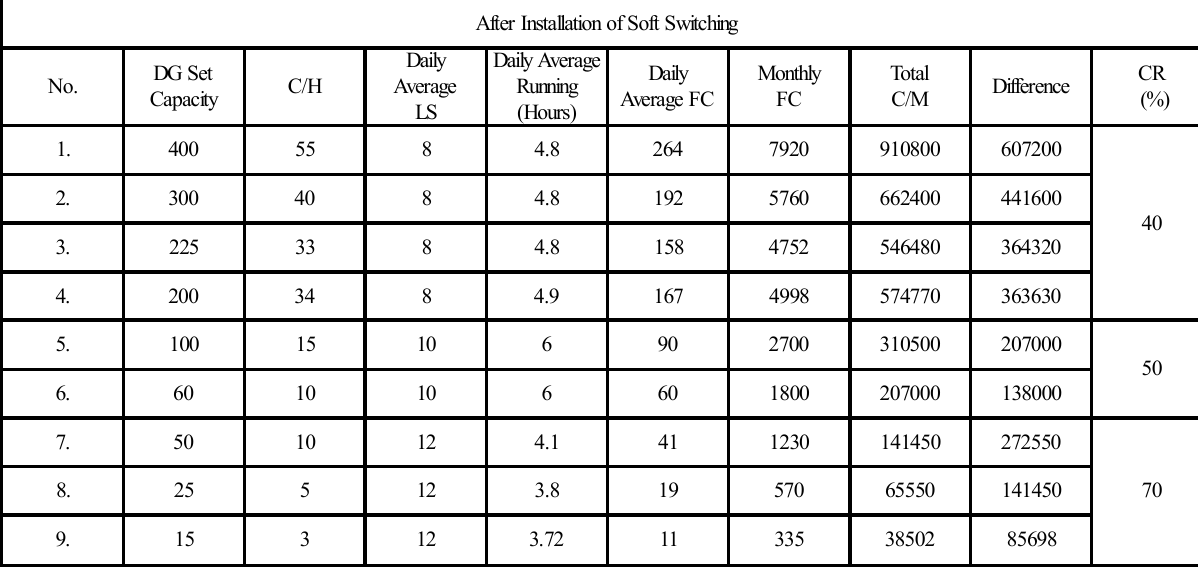
FIG. 5. GRAPHS SHOWING DIFFERENCE AND REDUCTION OF COST TABLE 2. CHART SHOWING OPERATION COST (AUTO